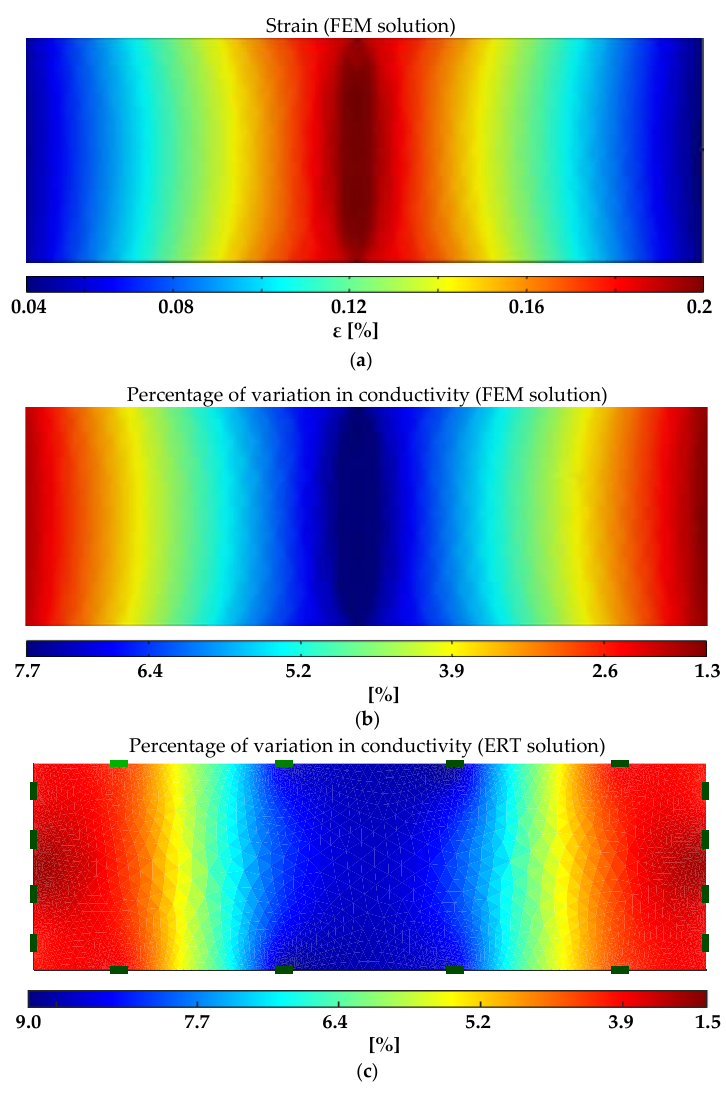
Figure 18. FR4 sample with the piezoresistive coating shown in Figure 6 subjected to a flexural test: ( a ) strain map and ( b ) corresponding map of the percentage of variation in conductivity simulated by COMSOL; ( c ) map of the percentage of variation in conductivity reconstructed from the ERT measurements.